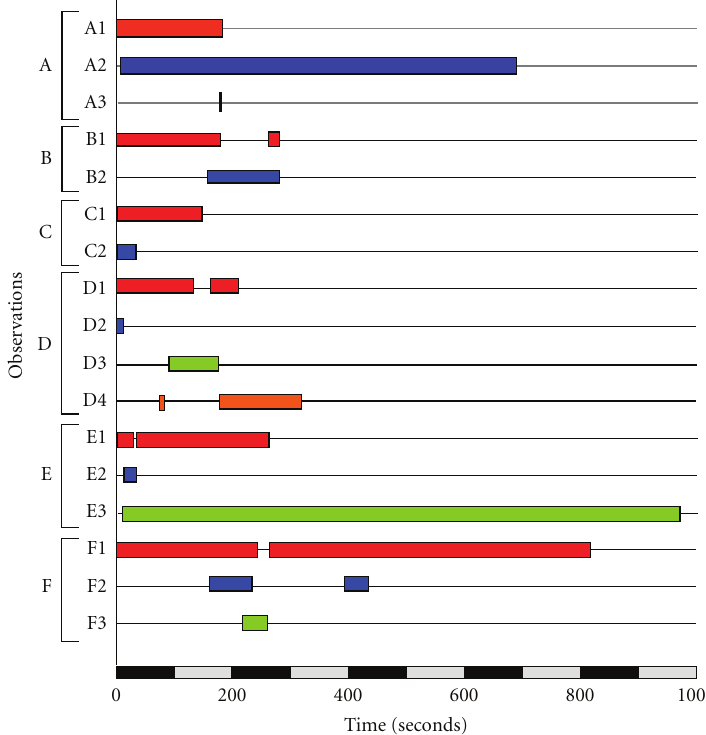
Figure 1: Duration of six video sessions of the interaction between di ff erent individuals of Odontomachus bauri attending nymphs of Xedreota tuberculata . The di ff erent colors represent di ff erent individuals of Odontomachus bauri observed